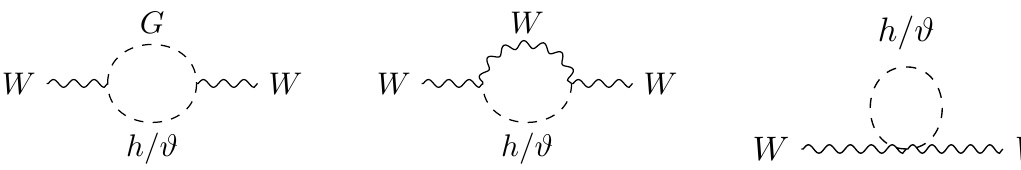
Figure 4. Feynman diagrams corresponding to the three W boson self-energy contributions in- volving the Higgs boson. We work in the Feynman gauge ( ξ = 1 ) and G stands for the charged SM Goldstone boson. Each SM h -vertex is suppressed by a factor of cos φ after the Higgs field mixes with the flavon field, but this is complemented by a set of identical diagrams with the physical flavon field running in the loop. Though not drawn here, the Z -boson self-energies are modified in a similar